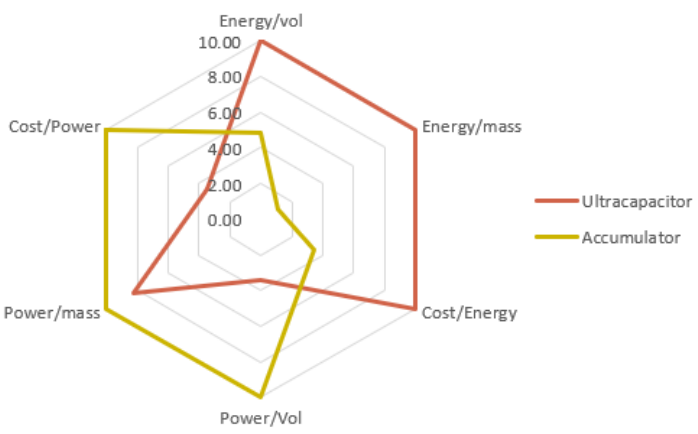
Figure 30. Radar plot comparing ultracapacitors and hydraulic accumulators.